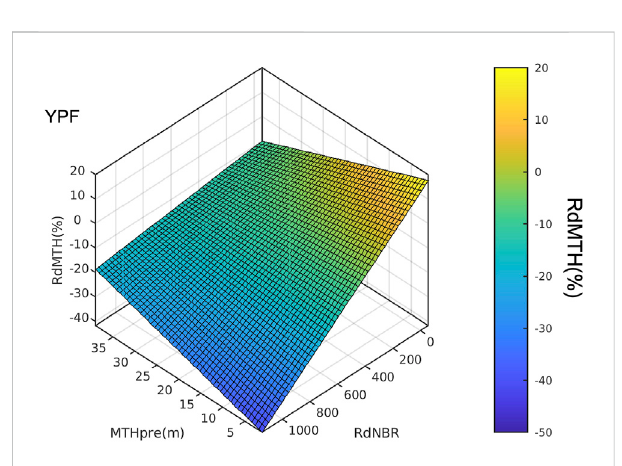
FIGURE 7 Relations between MTH pre , RdMTH, and RdNBR in yellow pine forests